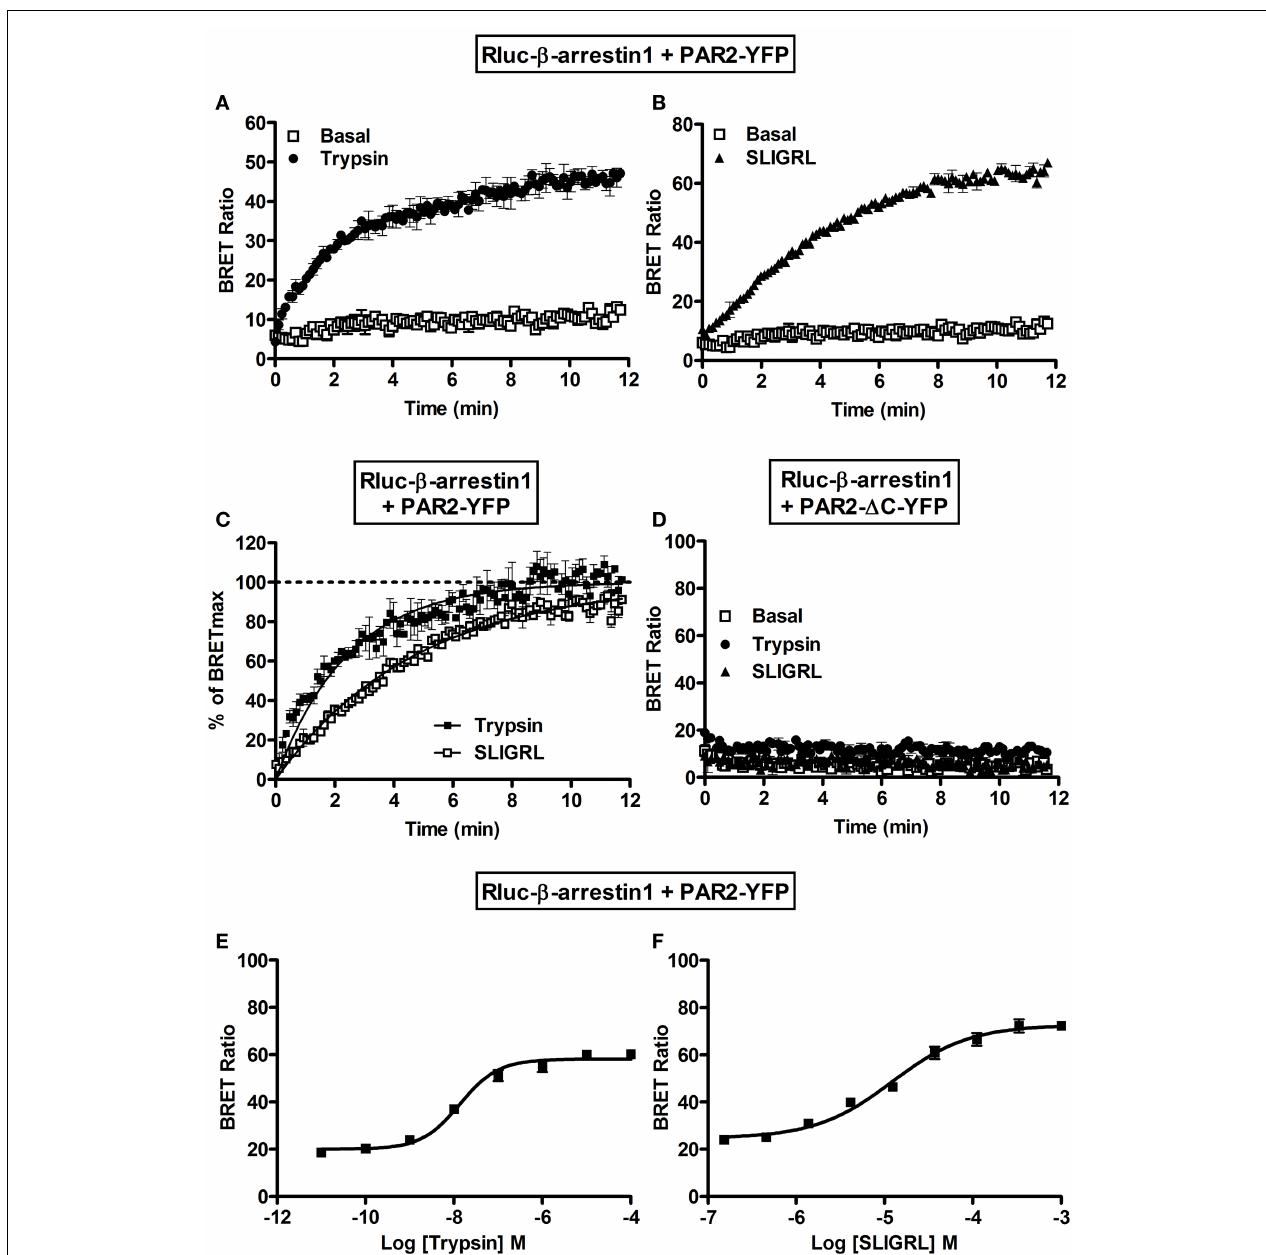
and the curves were fitted by Prism GraphPad fits of trypsin-induced BRET increase using “One phase exponential association” equation ( Y = Y max *(1 − exp( − K * X ))). Dose-response analysis on the increase of BRET • ) or signals between Rluc- β -arrestin 1 and PAR2-YFP upon stimulation with increasing concentrations of trypsin (E) or SLIGRL (F) as indicated. Data are means ± SEM of three independent experiments performed in